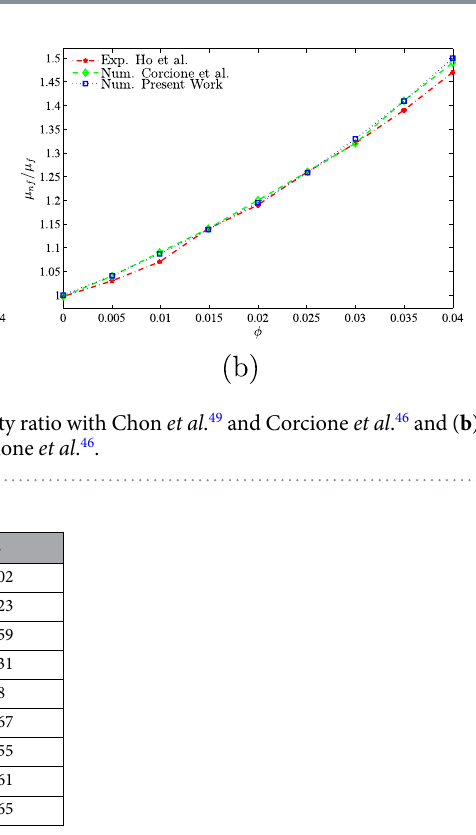
at different grid size for Ra = 10 5 , Ha = 15, φ = 0.02, k w = 0.76 and nf